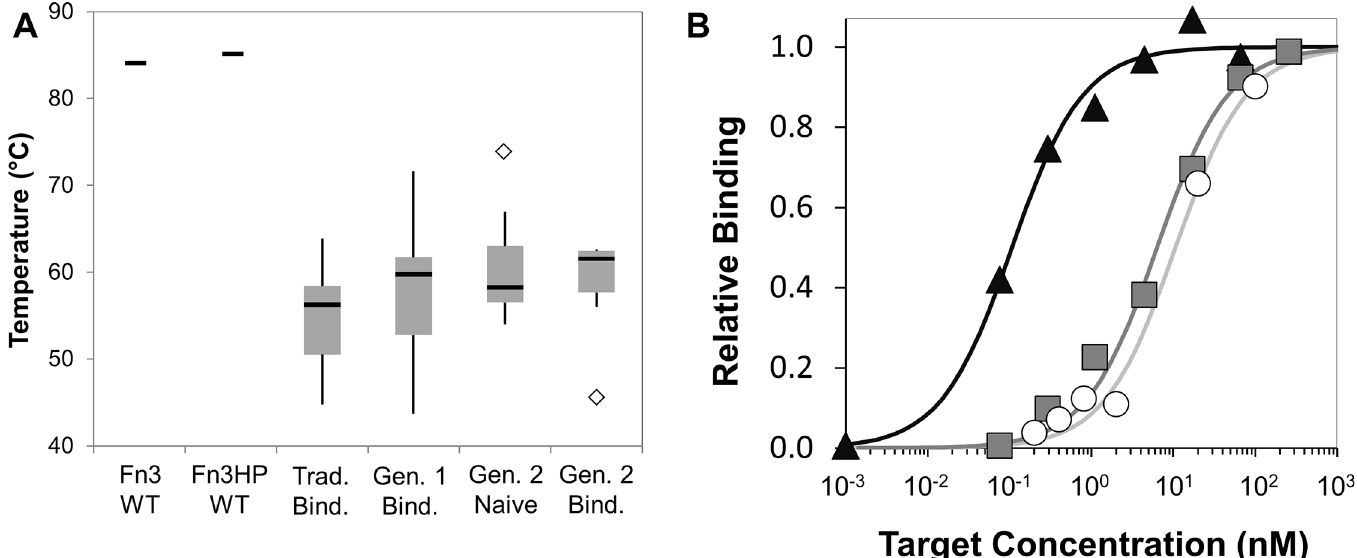
Fig 8. Clonal characterizations. (A) Thermal stabilities of wild-type (WT) fibronectin [80] and Fn3HP are shown. Median (black line), second and third quartiles (gray box), upper and lower inner fences (vertical lines), and outliers (diamonds) are shown for a sampling of clones from binarily diversified traditional libraries [37,66,80] (n = 15, Trad . Bind .) and three populations of the current study: first generation library binders, second generation na ï ve library, and second generation library binders. (B) Affinity titrations. Yeast displaying Fn3HP variants were incubated with the indicated concentration of biotinylated target molecule. Binding was detected by streptavidin-fluorophore and flow cytometry. Data points are from a single representative experiment. Affinities were calculated as 150 ± 60 pM (rabbit IgG, clone 0.6.2, black triangles), 4 ± 3 nM (lysozyme, clone 0.6.3, gray squares), and 11 nM (MET, clone 3.4.3, white